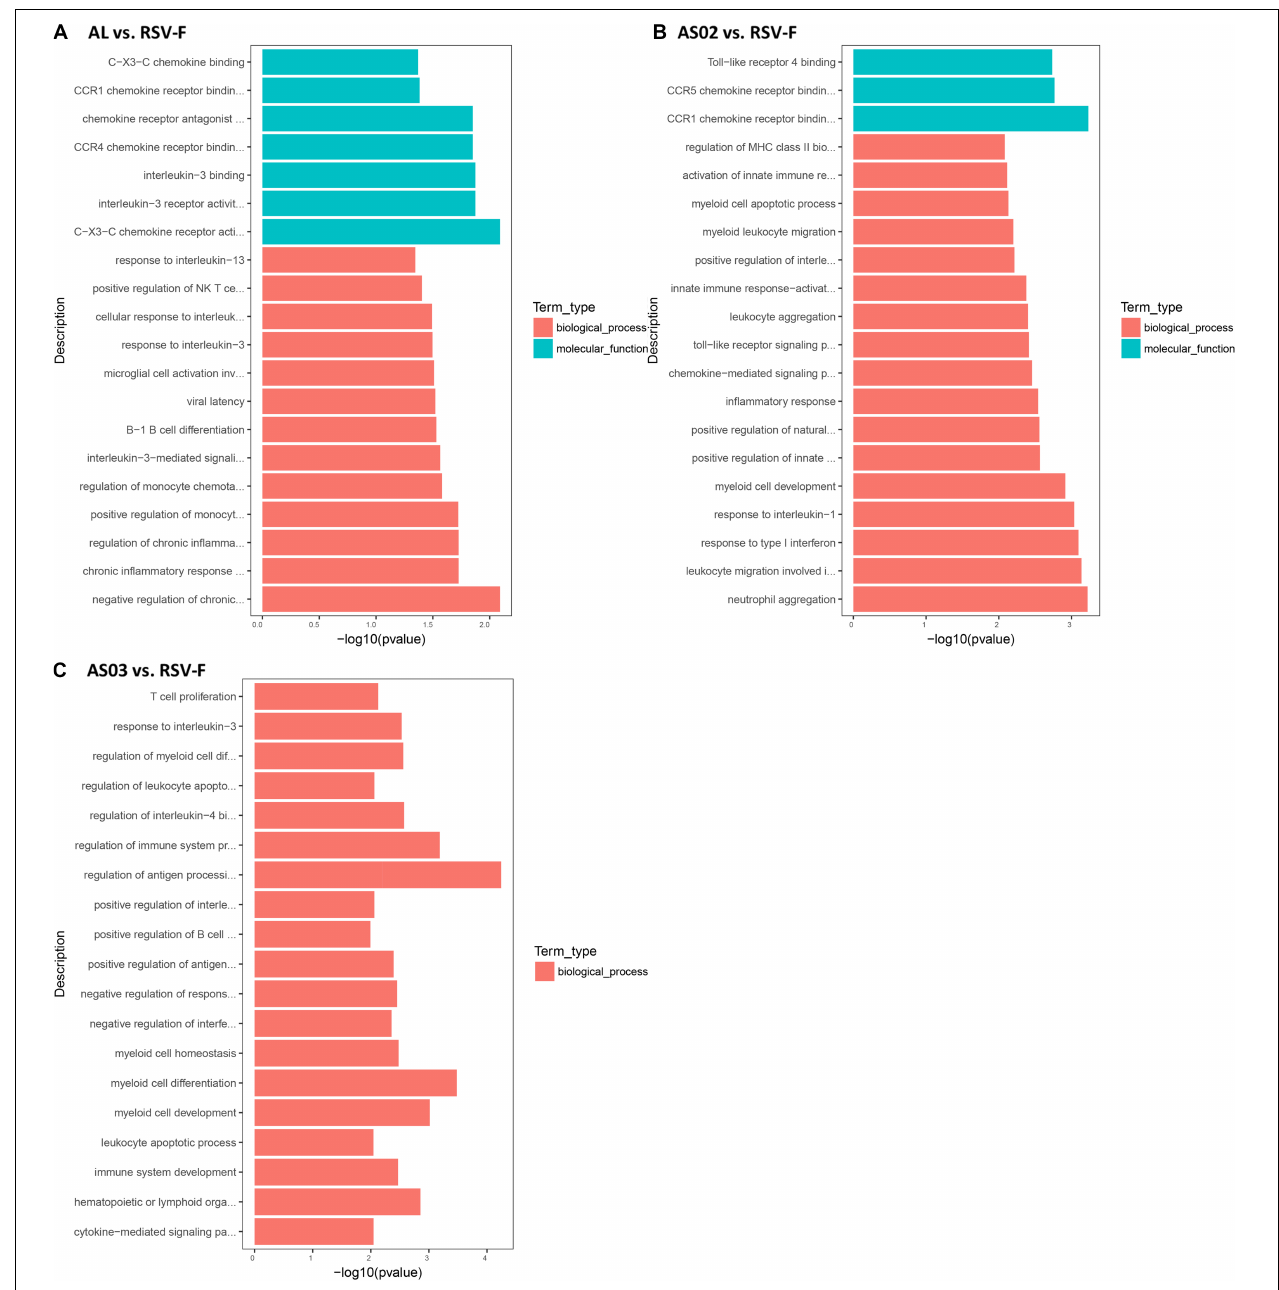
FIGURE 9 | Top 20 Immune-related GO enrichment results. DEGs (A) Al vs. RSV-F, (B) AS02 vs. RSV-F, and (C) AS03 vs. RSV-F were used for GO analysis. The x -axis indicates − log ( P -value). A greater x -value represents a more significant difference between the two groups. The y -axis represents the function descriptions of the GO